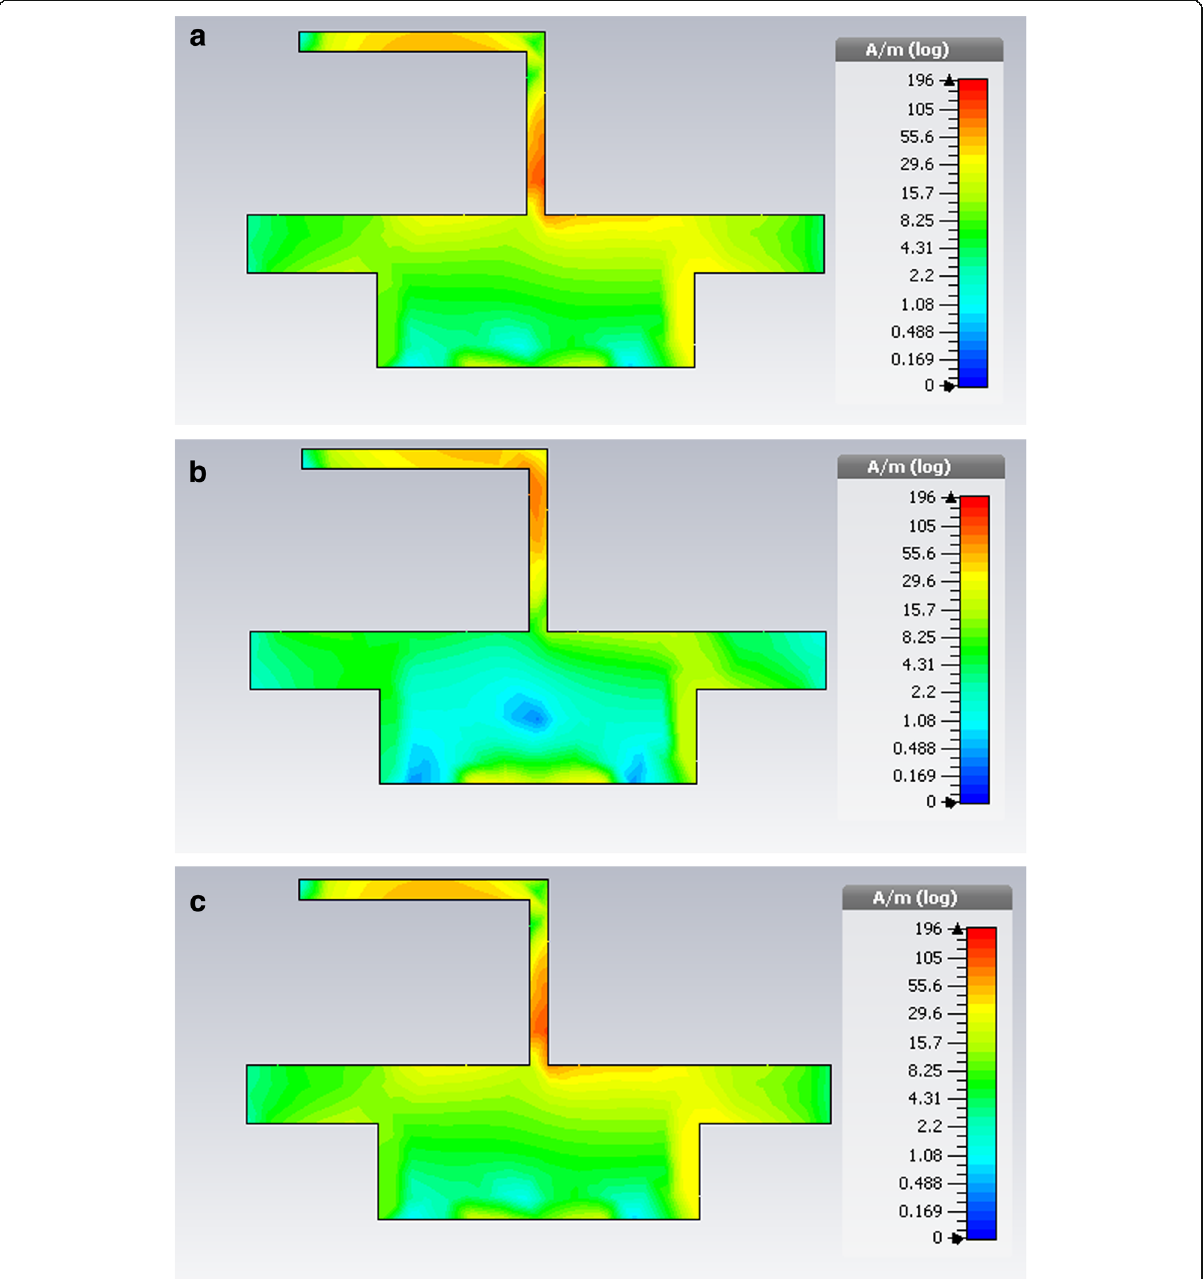
Fig. 9 Surface current distribution on the reflector at phase a 0°, b 90° and c 180° at 14